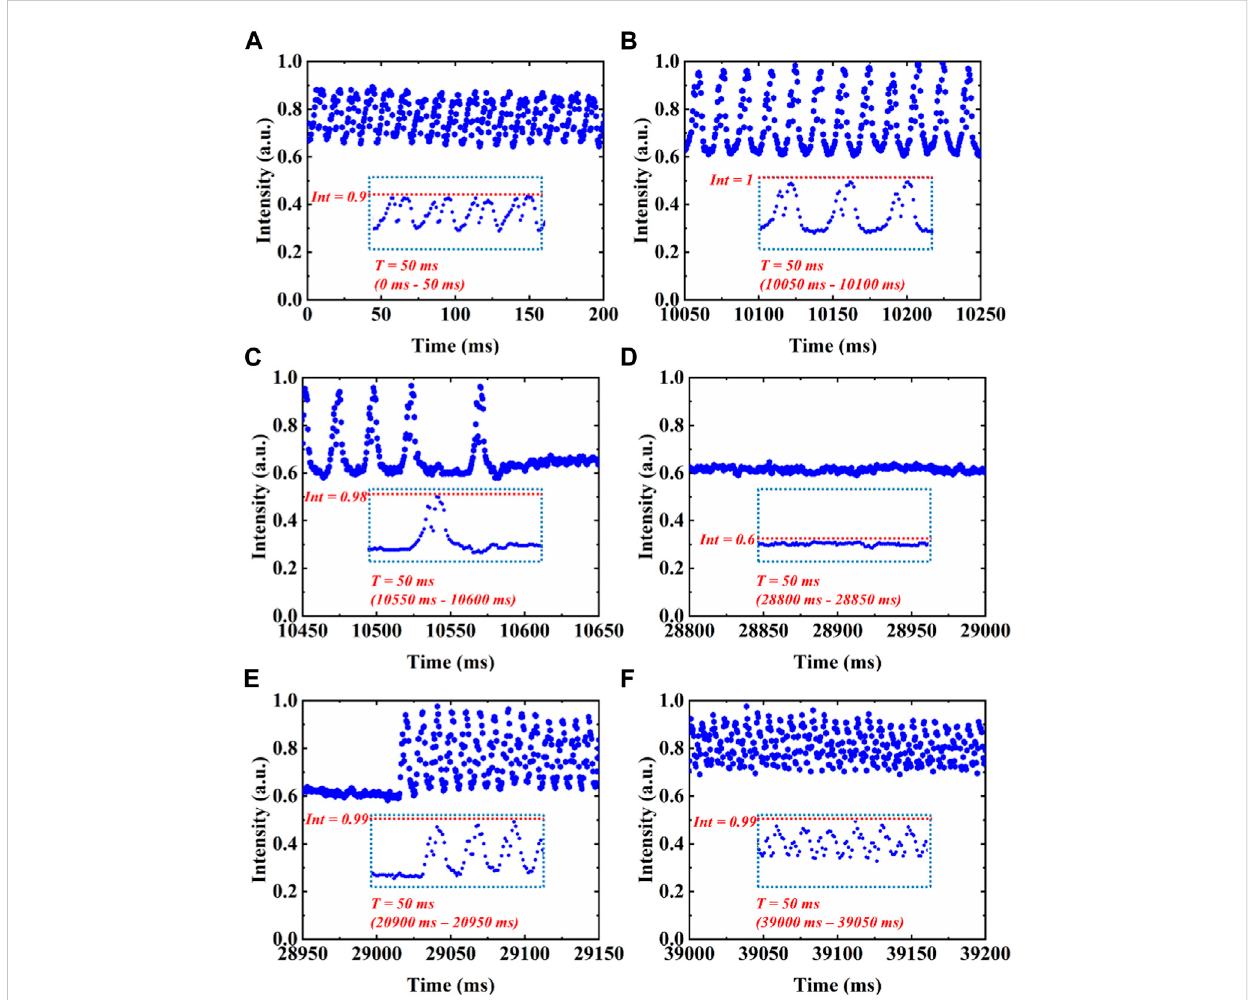
FIGURE 3 Variation of power in the far- fi eld bucket within multiple 200 ms at the pumping power of 357 W. Inset: selected 50 ms time window, where Int denotes the maximum